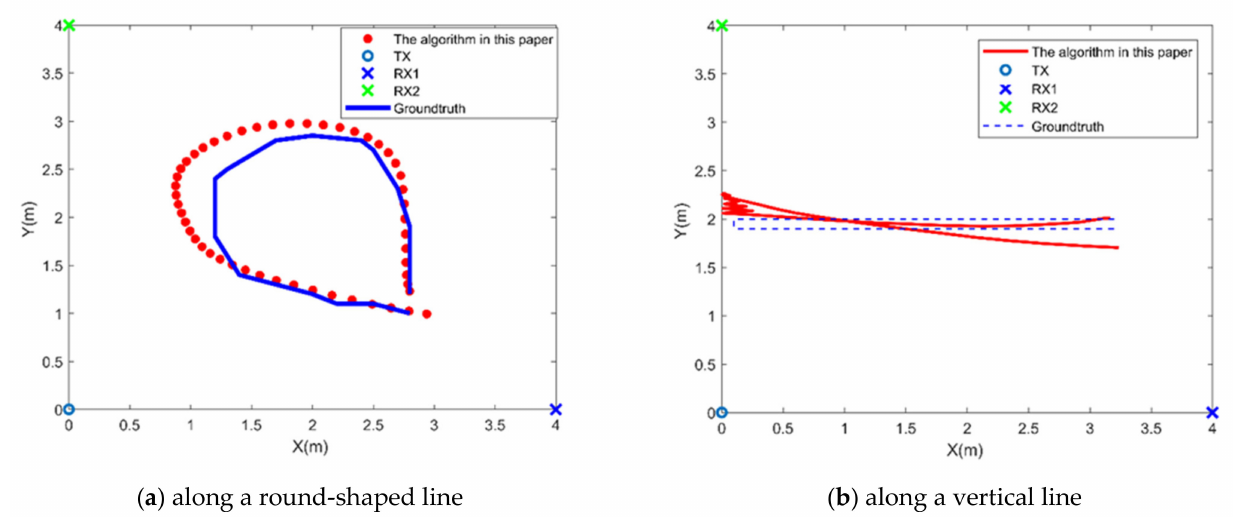
Figure 11. The trajectory prediction of a person walking in Environment 2. Figure 12 is the cumulative distribution function (CDF) of the tracking error in the two environments. Environment 2 is an empty and simple environment while Environment 1 is a complex environment. Experimental results show that the algorithm proposed in this paper can achieve good tracking and location results in both